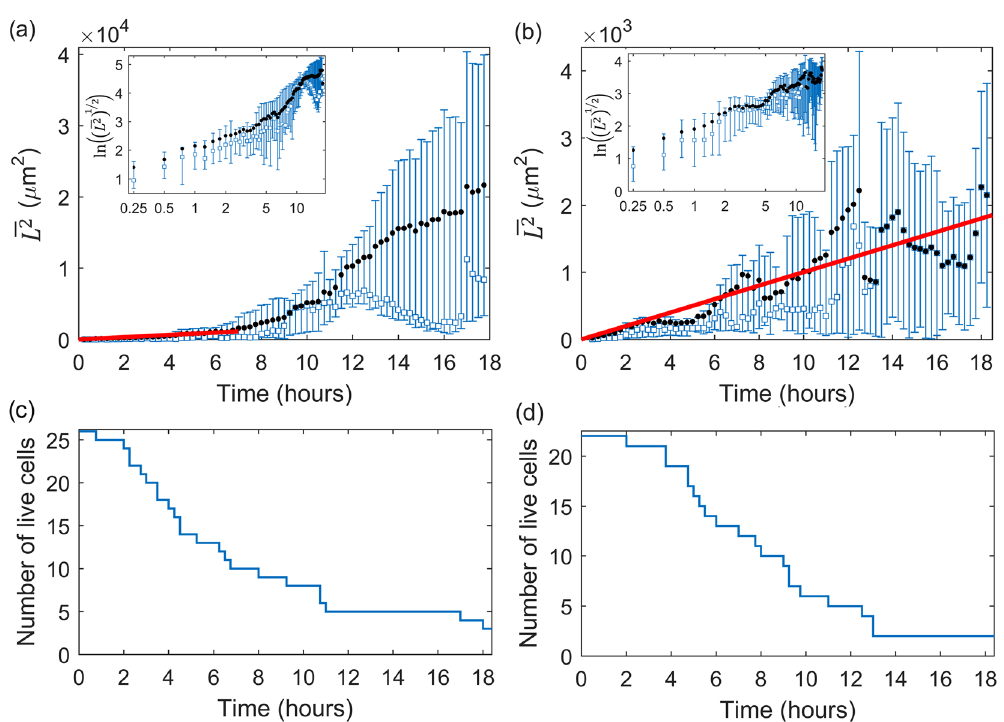
Figure 3. The evolution of the mean L 2 (black circles) and median (blue squares) displacements of single unstained cells ( a ) and stained cells ( b ) with red lines showing straight-line least-squares fits (constrained to pass through the origin) of = L Dt 2 2 with D = 79.8 ± 5.2 μ m 2 /hr for unstained cells and D = 49.1 ± 3.5 μ m 2 /hr for stained cells. Error bars show the upper and lower quartiles. Insets show the root-mean-square displacement L ( ) 2 1/2 vs time on natural logarithmic axes. The number of live cells over time for unstained cells ( c ) and stained cells ( d ) indicate the changing sample size. The sampling interval is 15